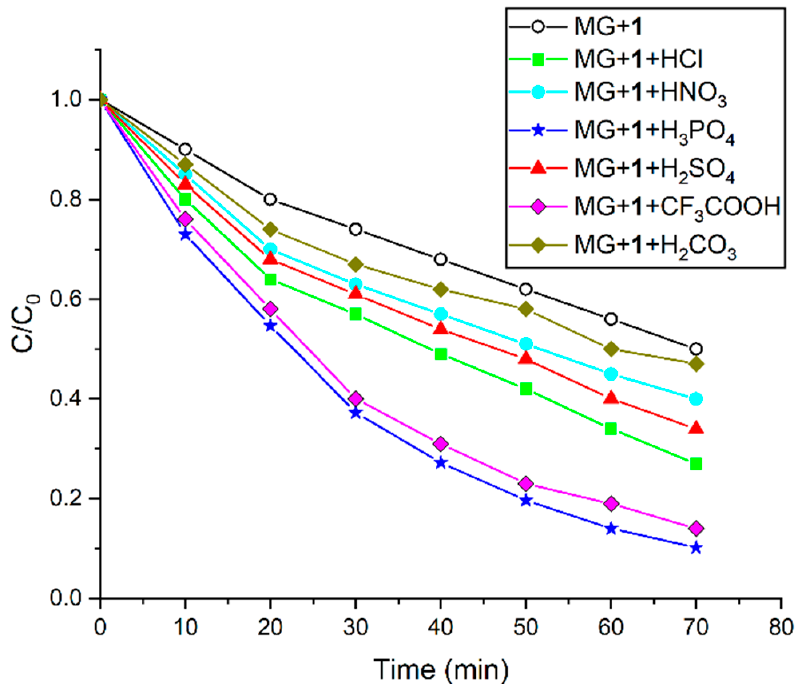
Figure 8. Photocatalytic degradation of MG dye in aqueous solution (pH 7, temperature 298 K) under visible light irradiation by photocatalysts generated from compound 1 with various acids.